Question: What caption would you write for this figure?
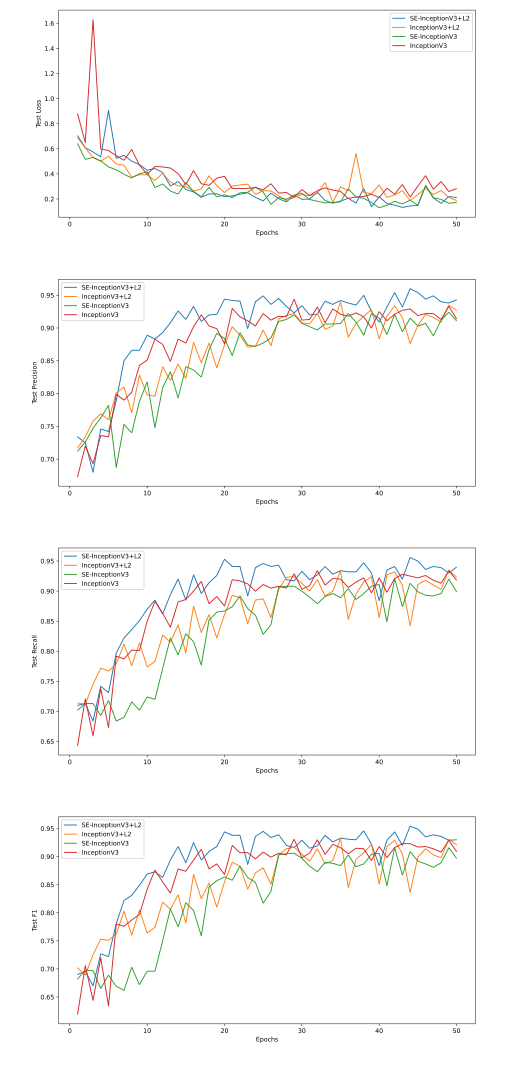
Answer: Loss, Precision, Recall, and F1 curves for